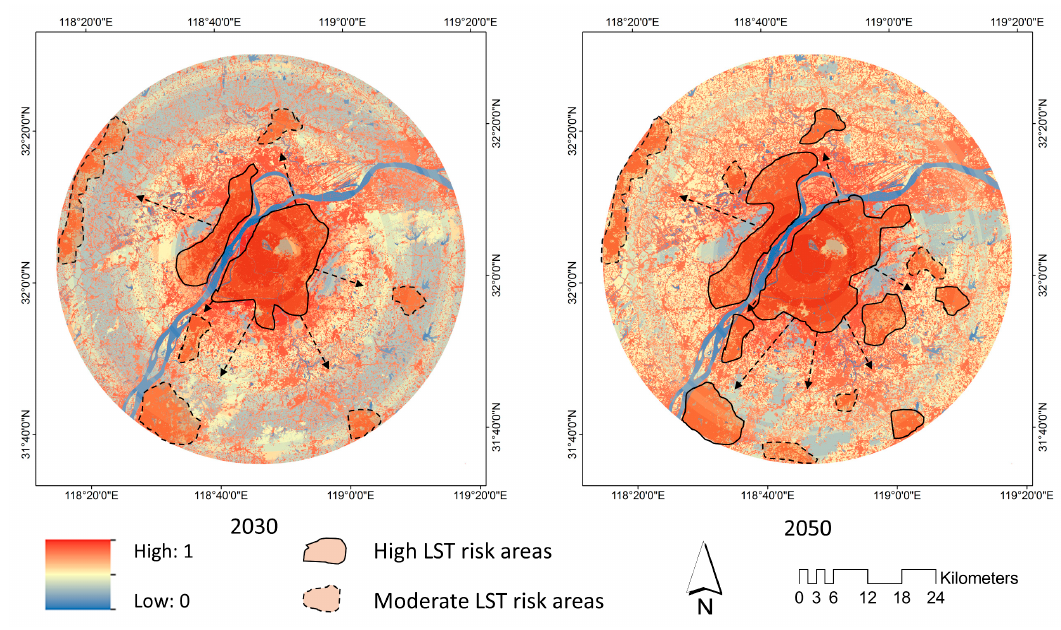
Figure 10. LST risk areas of Nanjing in 2030 and 2050.